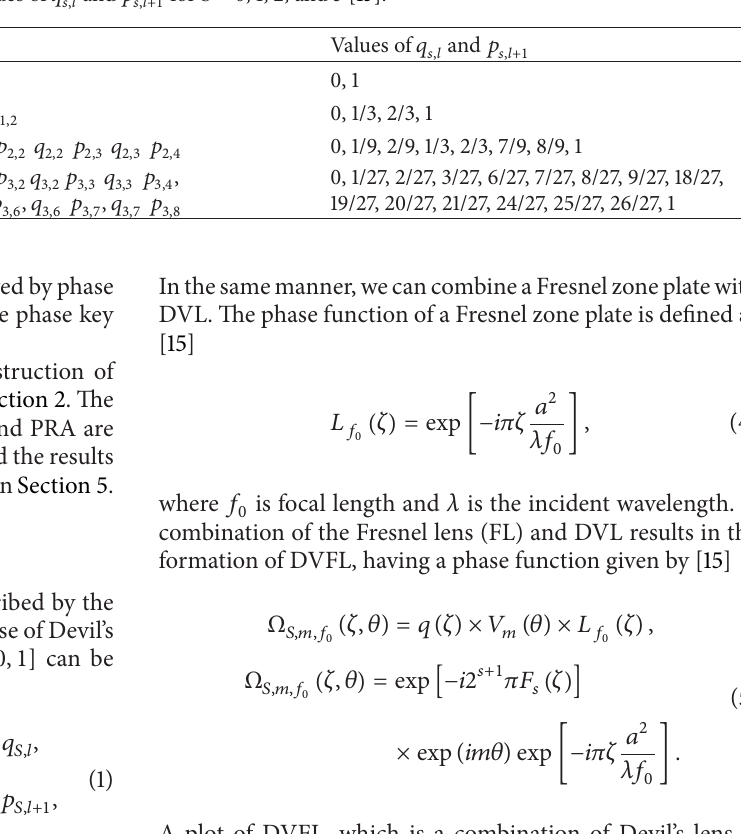
Table 1: Values of 𝑞 𝑠,𝑙 and 𝑝 𝑠,𝑙+1 for S = 0, 1, 2, and 3